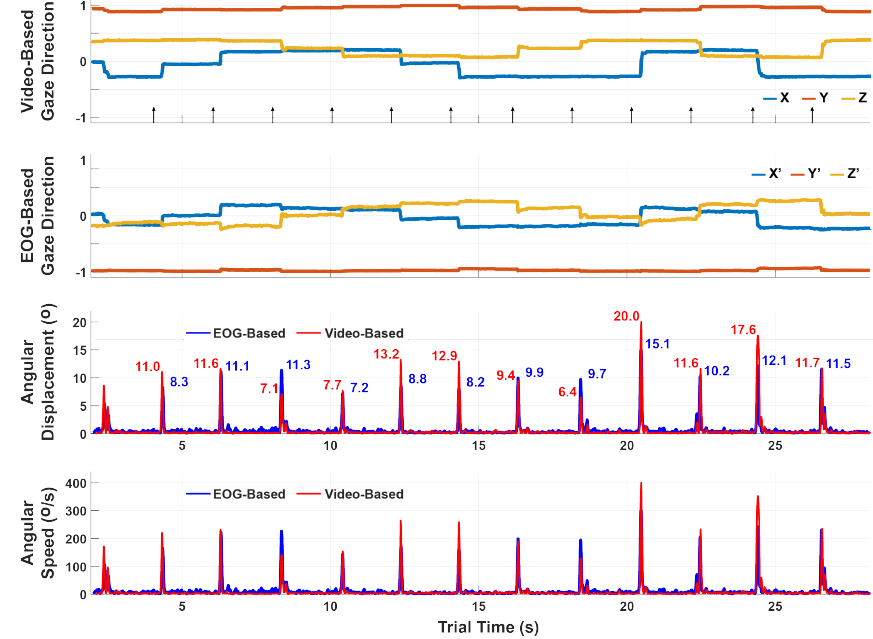
Figure 6: Comparison of the video-based and EOG-based gaze estimates during the saccade-phase. The top two plots show the gaze estimates themselves, which are in different coordinate systems. The bottom plots show the angular displacements and speeds over a sliding window of 50 ms . Unlike the gaze estimates which cannot be compared component-to-component, the angular displacements are coordinate-free and can thus be compared to assess performance. The discrepancy for this trial is 2.73 ° ± 1.92 ° RMS between video-based and EOG-based angular displacement